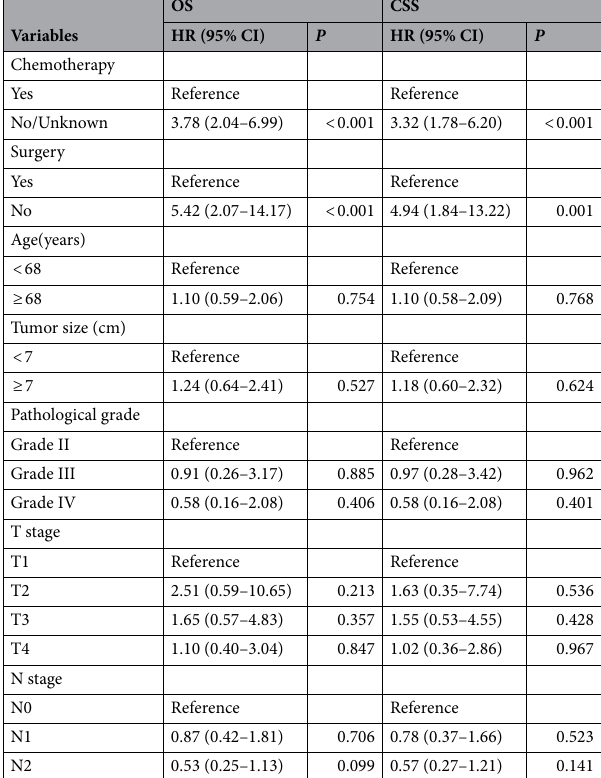
Table 5. DAG-Guided Multivariable Cox Regression Model Analysis for Causal Effects of Chemotherapy on OS and CSS. CDC, renal collecting duct carcinoma; DAG, directed acyclic graphs; CI, confidence interval; HR, hazard ratio; OS, overall survival; CSS, cancer-specific